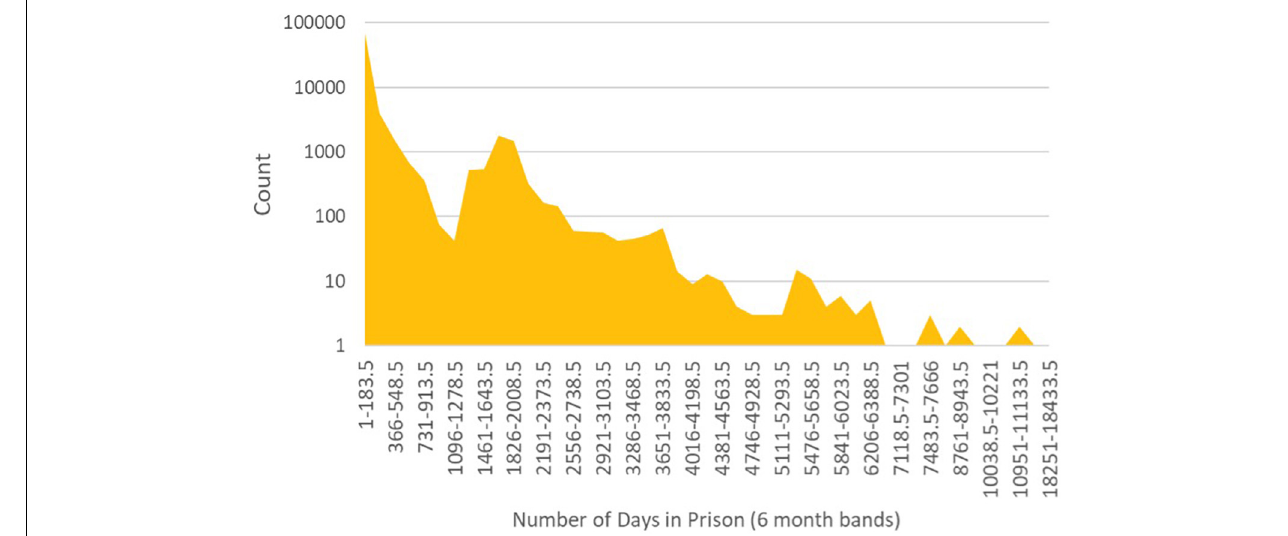
FIGURE 3 | Proportions of risk assessment score by ethnicity banding.